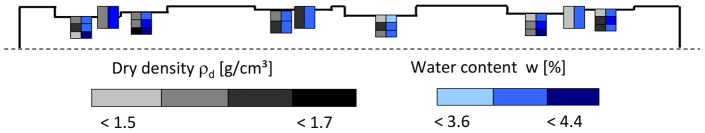
Results of dry density and water content profile measurements.Soil samples were obtained from the prepared test field by manual sampling with a metal tube. Samples were taken inside and outside several footprints, indicated by differing sampling depths, i.e., differing starting points of the top of the tube. Footprints are displayed schematically, for detailed information see Figure 11.